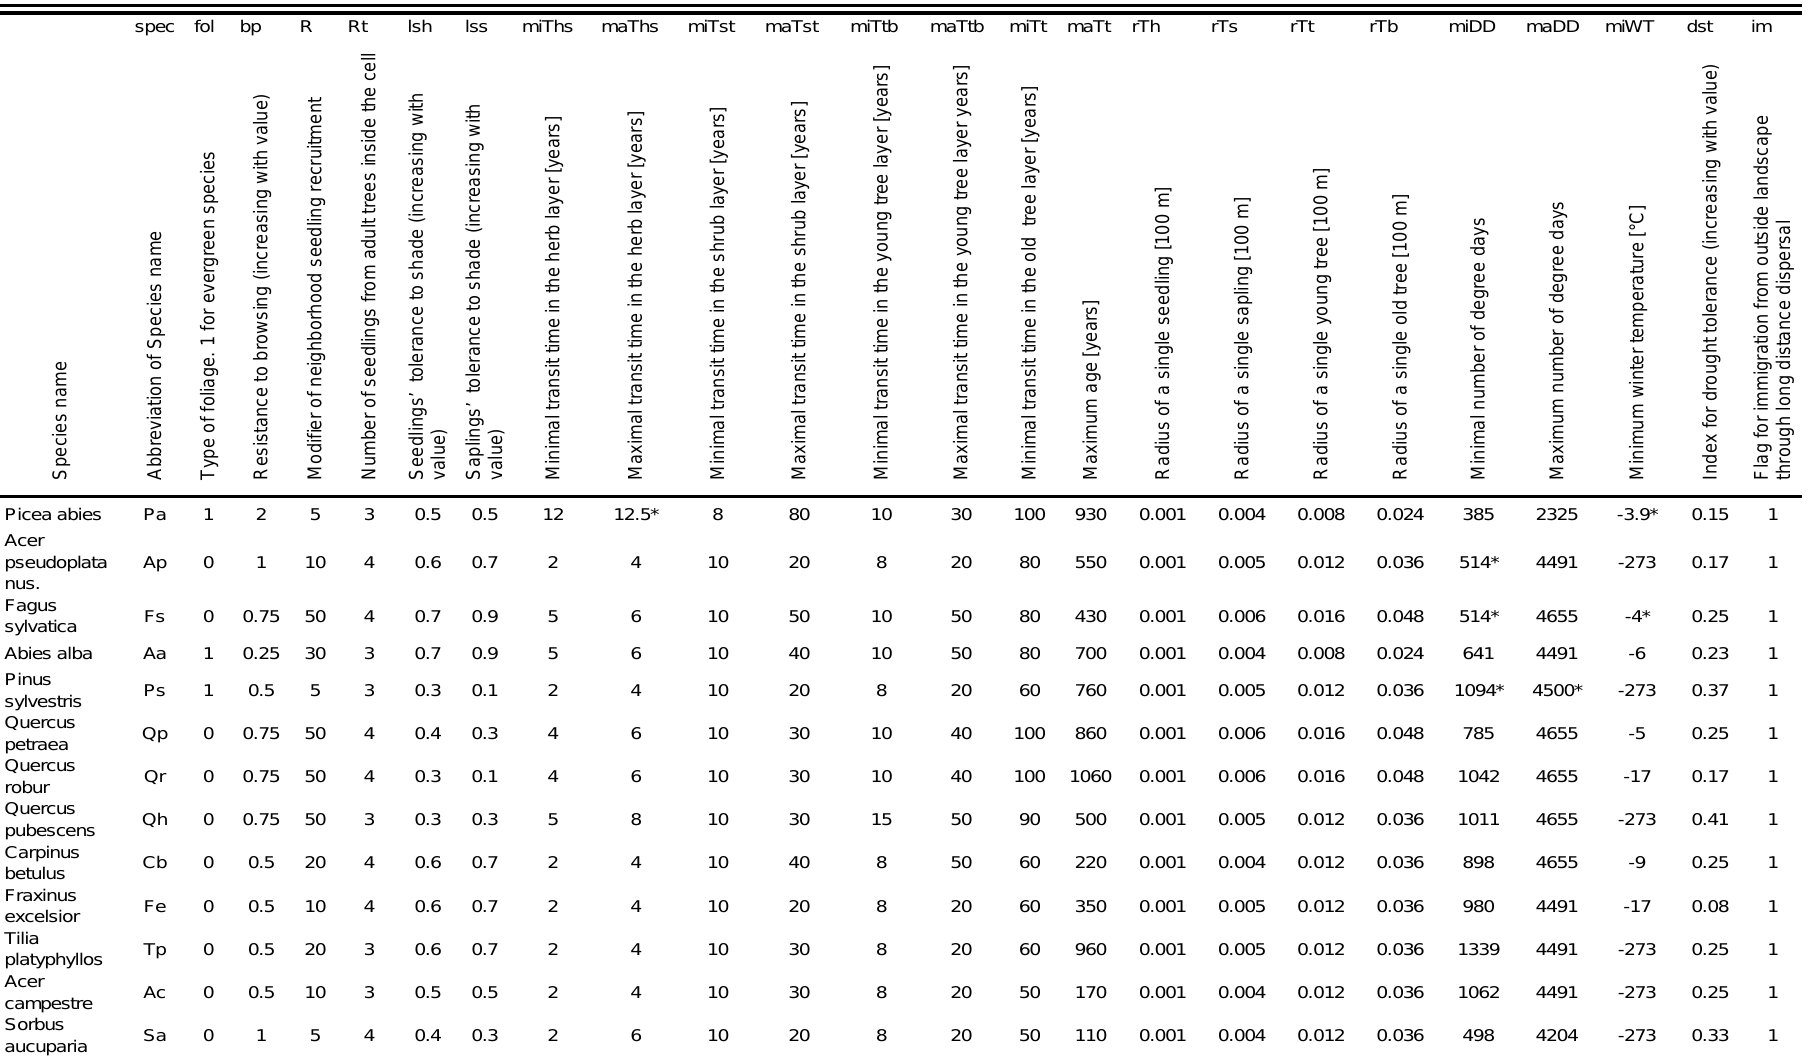
Table A1. Tree species parameters. Parameters with an asterisk (*) are adapted to oceanic climate as described in the